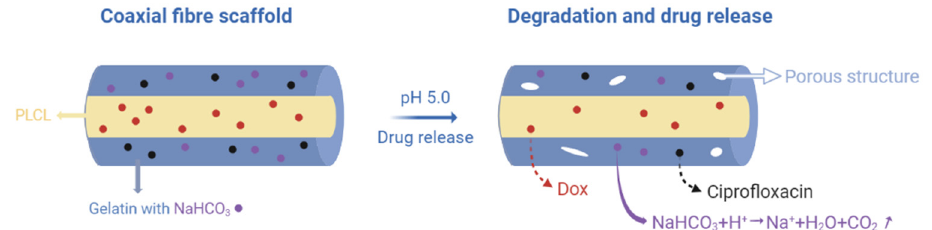
Figure 2. A schematic illustration of this experimental strategy. Created with BioRender.com and adapted from